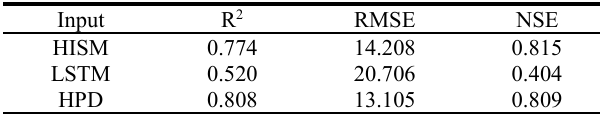
Table 2 . runoff simulation in flood period. For the optimal LSTM model, the number of neurons in each hidden layer is 40, the number of training iterations is 15000, and the learning rate is 0.0002. The dropout regularization method was used to prohibit overfitting, and the value is set to